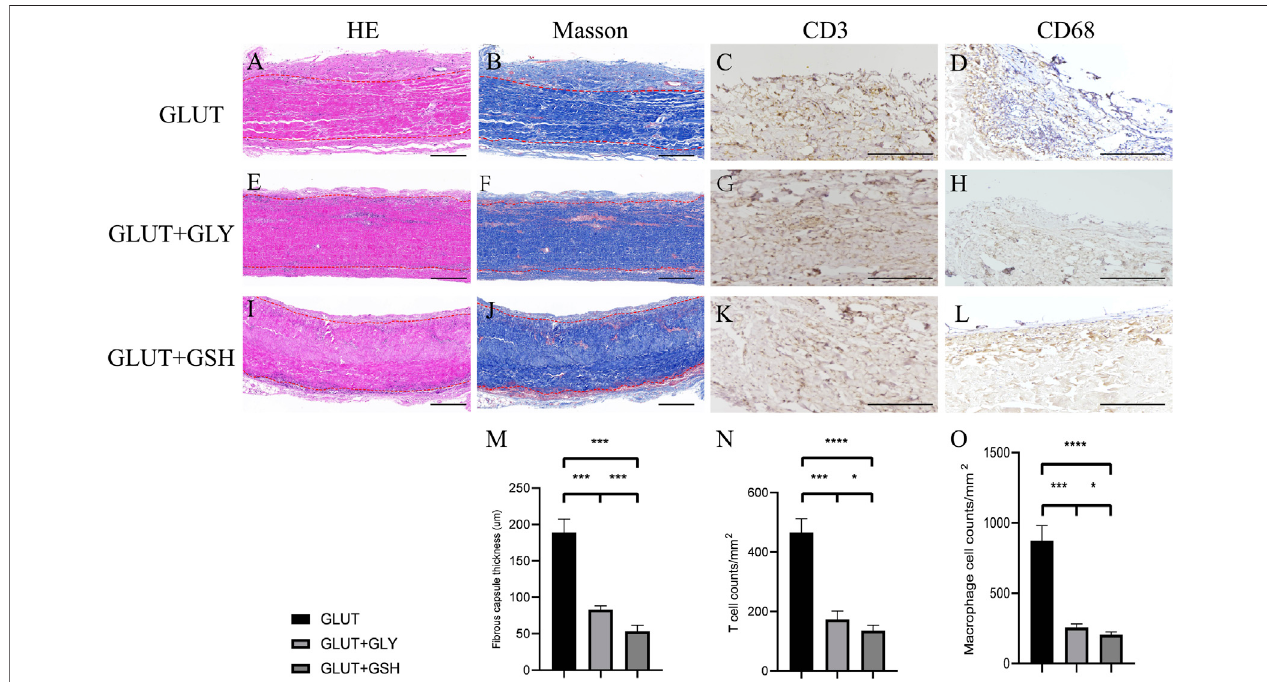
FIGURE6| Invivo biocompatibilityofBPsfromGLUT-BP (A – D) ,GLUT+GLY (E – H) ,GLUT+GSH (I – L) .The (M – O) istheFibrouscapsulethicknessandcountof T cell and macrophage cell ( n = 4; p p < 0.05; pp p < 0.01; ppp p < 0.001; pppp p < 0.0001; ns represents no signi fi cant